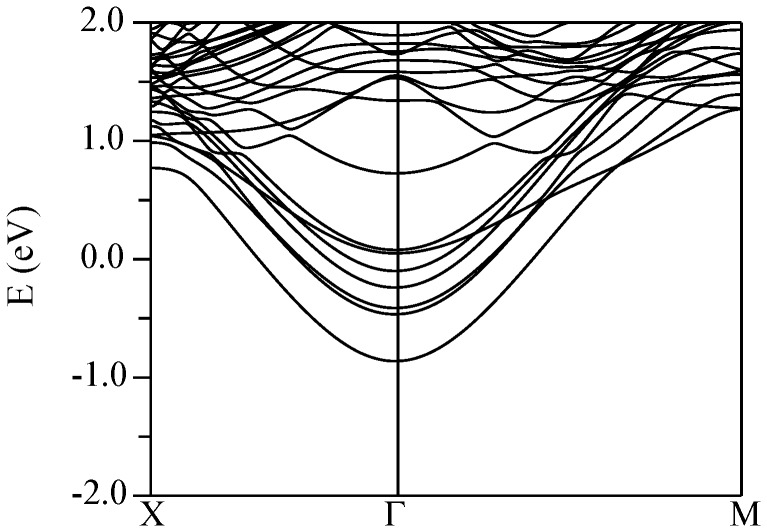
Calculated conduction band structure of the relaxed (KNbO3)//(ZnSnO3) supercell (see text) using the TB-mBJ potential.The Fermi energy is at 0 eV.